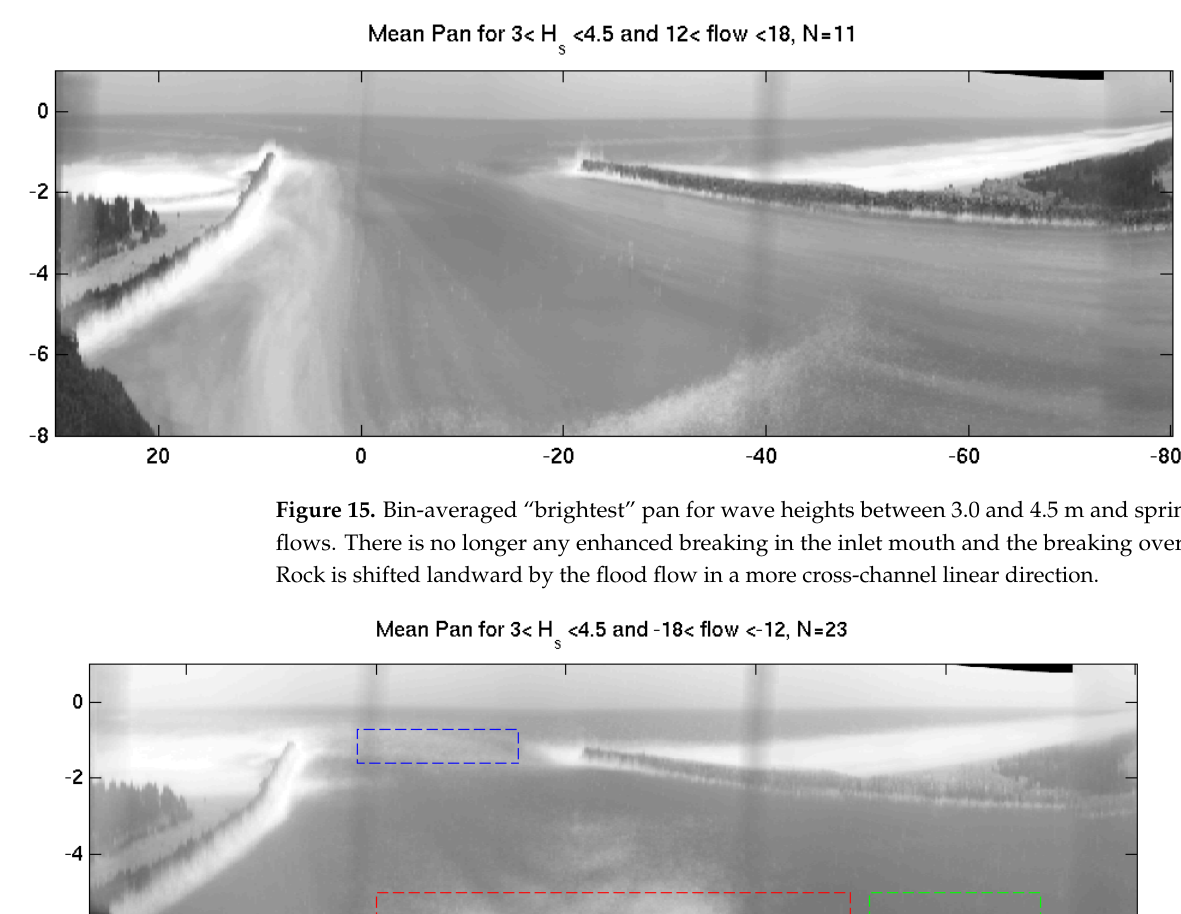
Figure 14. Bin-averaged “brightest” pan for wave heights between 3.0 and 4.5 m and spring ebb flows. The enhanced breaking over Guano Rock continues but the breaking at the mouth of the inlet is more evident.